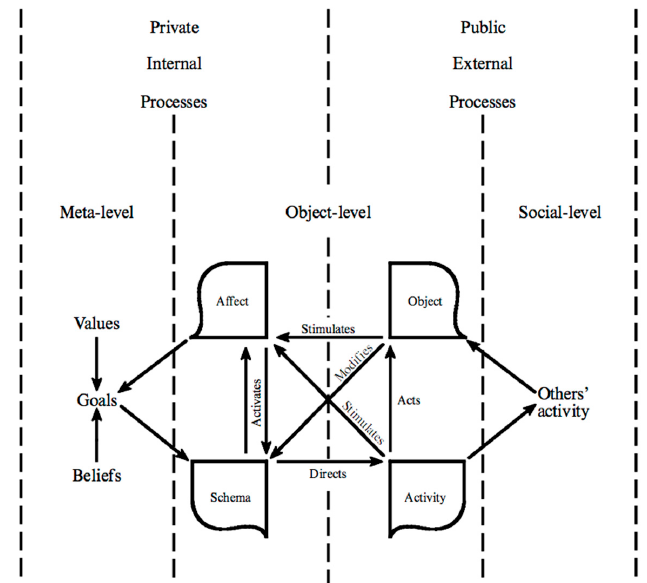
Figure 5. Activity cycle theory (ACT) consists of four systems, three representing a functional module for a psychological domain (a ff ect, schema, activity) and one (object) representing physical objects or internal images and ideas. Private (internal) and public (external) processes are executed across the meta level, object level, and social level of organization. The system enables outcomes of alternative future actions to be appraised prior to committing to any course of action. Conscious imagery serves as a mental “toolbox”, providing its internal contents for the user to explore in the selection and preparation of future physical and social activity. The a ff ect system co-activates goals and schemata enabling the organism to strive toward desired outcomes. Please note that psychological homeostasis was not included in the ACT. However, the ACT formulation was a crucial step in formulating the General Theory of Behavior. Reproduced from Reference [33] with